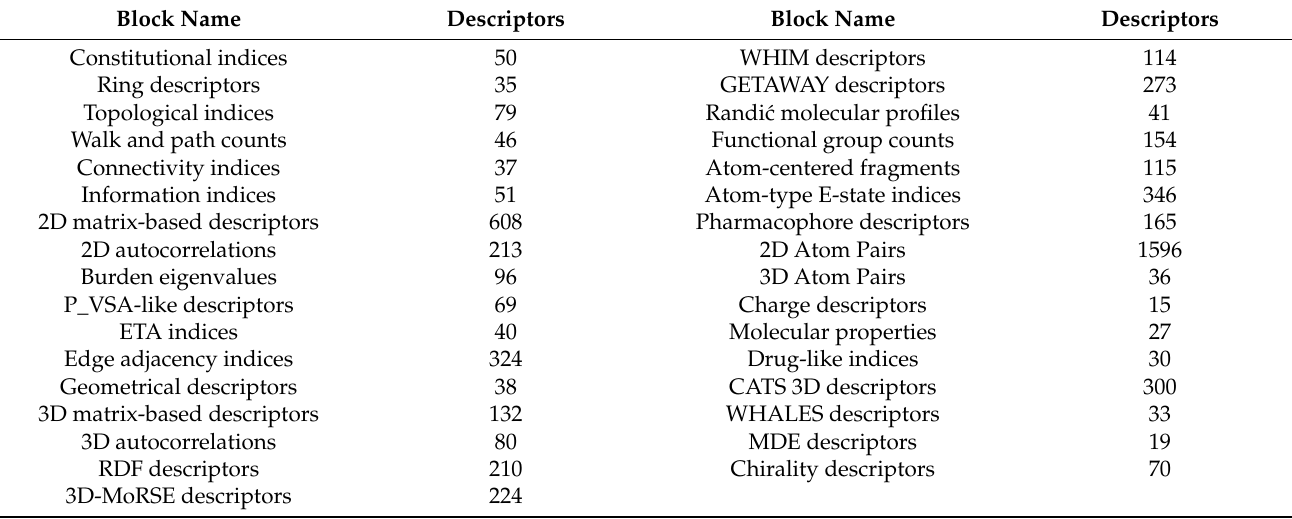
Table 3. List of alvaDesc descriptors